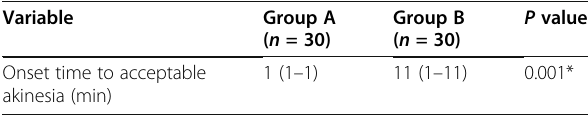
Table 7 Comparison between group A and B as regards onset time to acceptable akinesia score